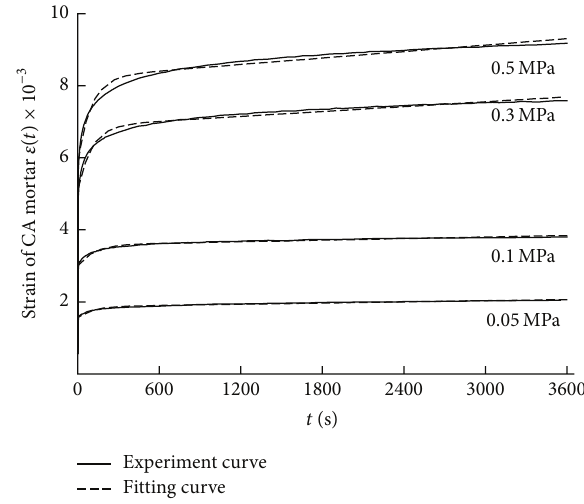
Figure 4: Fitting curves of Burgers model and experimental curves of CA